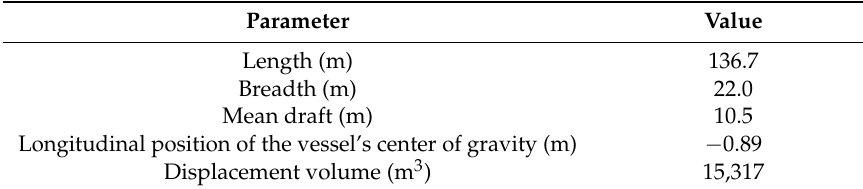
Table 1. Main parameters of the